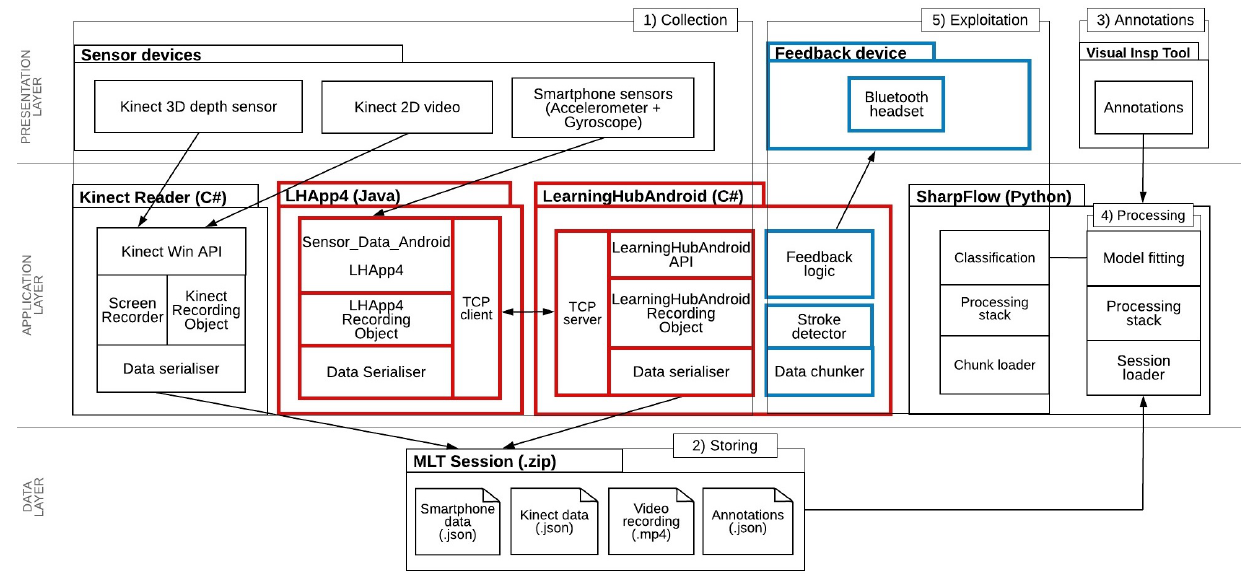
Figure 3. The Project Architecture with the following elements: (Red lines/boxes) New components developed for this study. (Blue lines/boxes) Future